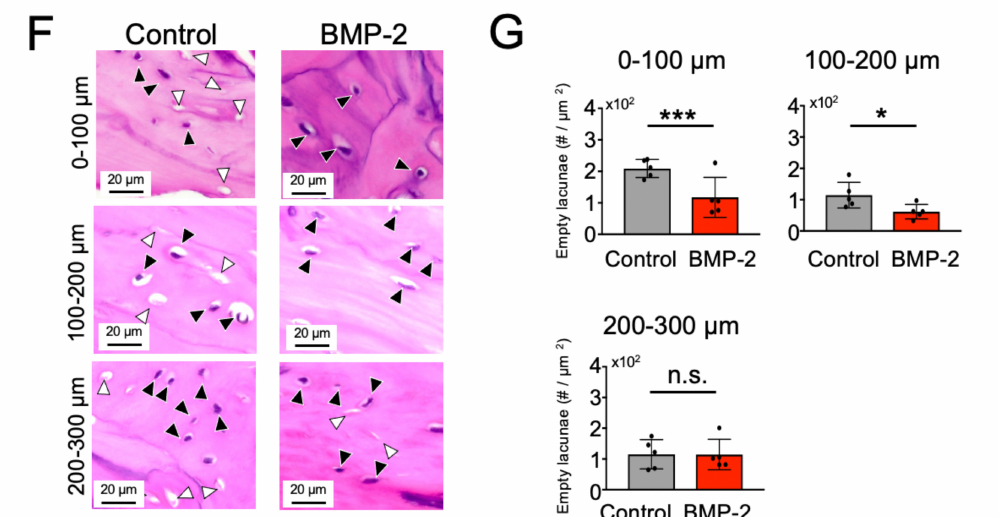
Figure 3. Effect of BMP-2/ β -TCP transplantation on the bone surrounding the tooth extraction socket in a MRONJ-like prevention model. ( A ) Experimental design: BMP-2/ β -TCP complex was transplanted into the socket after extraction of the maxillary first molar at three weeks. After four weeks post-transplantation, mice were sacrificed and submitted for analysis. CY/ZA was administered continuously throughout seven weeks. CY: cyclophosphamide, ZA: zoledronate. ( B ) Representative micro-CT images of the tooth extraction socket and the surrounding alveolar bone in the control and BMP-2/ β -TCP-transplanted groups. Red arrow indicates residual BMP-2/ β -TCP. White dotted line shows the tooth extraction socket. Green and red squares mark the furcation and mesial areas of the alveolar bone (100 µ m 2 , ROI) adjacent to the tooth extraction socket, respectively. ( C ) Quantitative analysis of bone mineral density (BMD) of the mesial and furcation areas of the alveolar bone adjacent to the tooth extraction socket. The bar graph was presented as mean ± standard deviation; *** p < 0.001, unpaired Students’ t -test, n = 4–6. ( D ) HE-stained sagittal images of bone surrounding the tooth extraction sockets of control and BMP-2/ β -TCP-transplanted group. Yellow line indicates the tooth extraction socket. ( E ) Graphic image of the selected bone area around the tooth extraction sockets. Green, red and purple lines represent the areas at 0 µ m to 100 µ m, 100 µ m to 200 µ m and 200 µ m to 300 µ m from the surface of tooth extraction socket, respectively. ( F ) HE-stained sagittal images of the selected bone area around the tooth extraction sockets at 0 µ m to 100 µ m, 100 µ m to 200 µ m and 200 µ m to 300 µ m from the surface of tooth extraction socket, respectively, in the control and BMP-2/ β -TCP-transplanted group. Black and white arrowheads represent lacunae with and without cells, respectively. ( G ) The graph shows the quantitative analysis of empty lacunae in the bone surrounding the tooth extraction socket. The number of empty lacunae was significantly decreased in the BMP-2/ β -TCP-transplanted group compared to that in the control group. The bar represents the mean ± standard deviation. *** p < 0.001, * p < 0.01, ns: no significant difference. unpaired Students’ t -test, n =